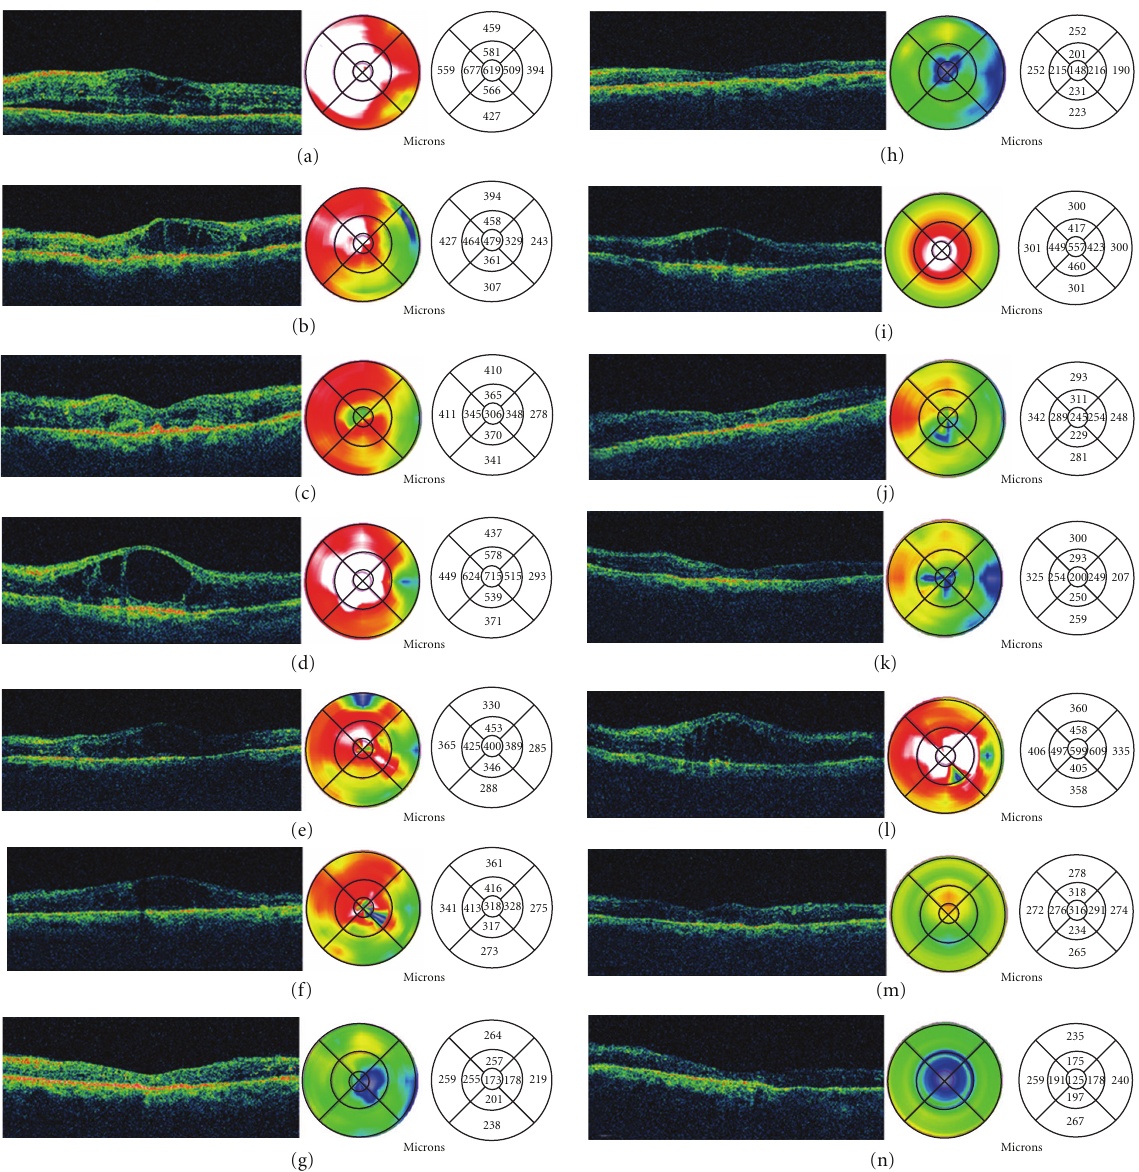
Figure 3: Sequential optical coherence tomography (OCT) of a 69-year-old diabetic woman with a 6-months history of lost of vision to counting fingers (CF) in her left eye that had developed diabetic macular edema